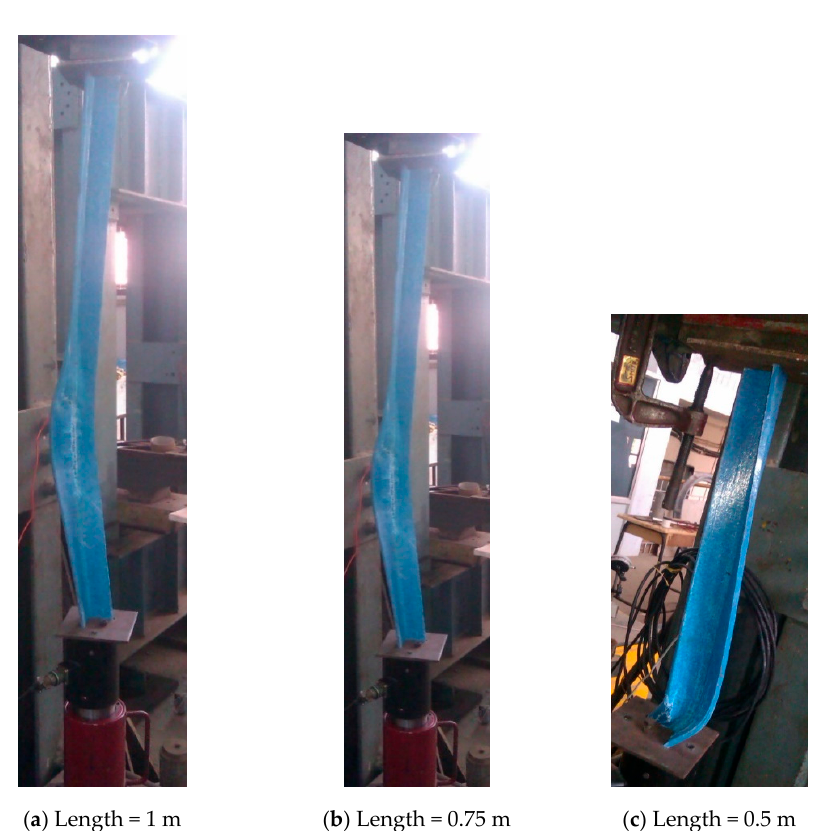
Figure 5. Buckling behavior of GFRP angle sections 50 mm × 50 mm × 6 mm.